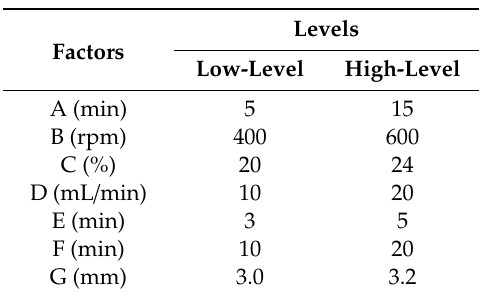
Table 1. Factors and levels of D-optimal design.